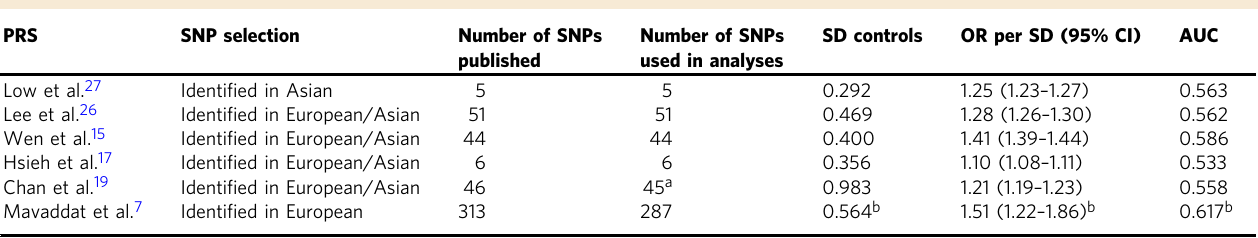
Table 6 Association between Asian-speci fi c PRSs and overall breast cancer risk.